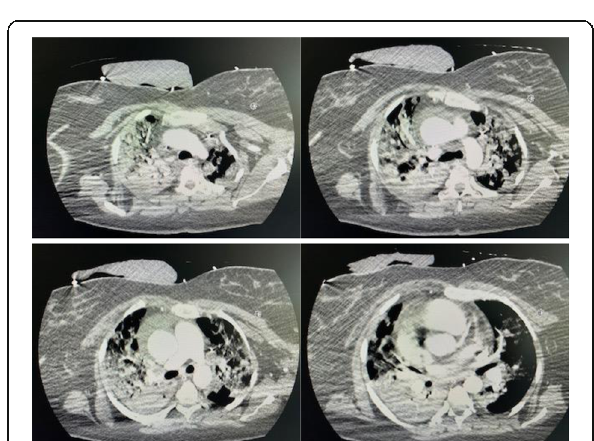
Fig. 2 (abstract A159). See text for